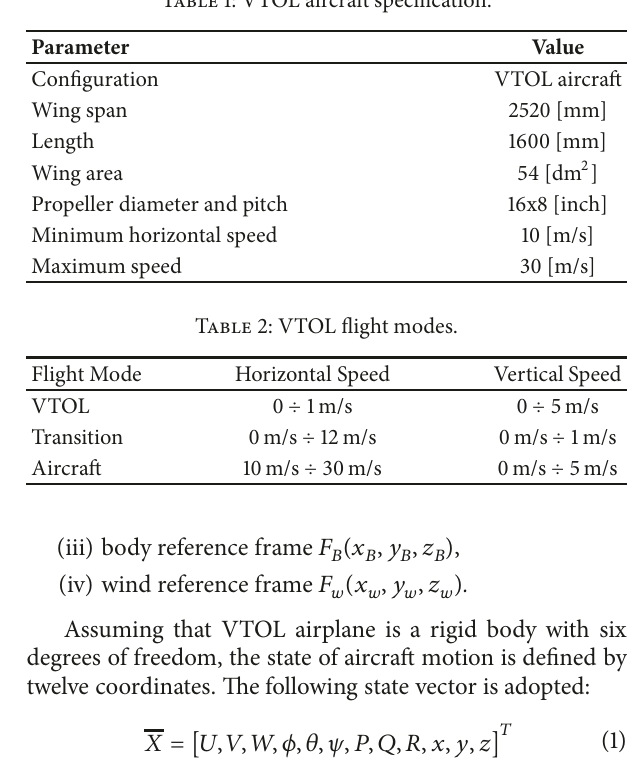
Table 1: VTOL aircraft specification.